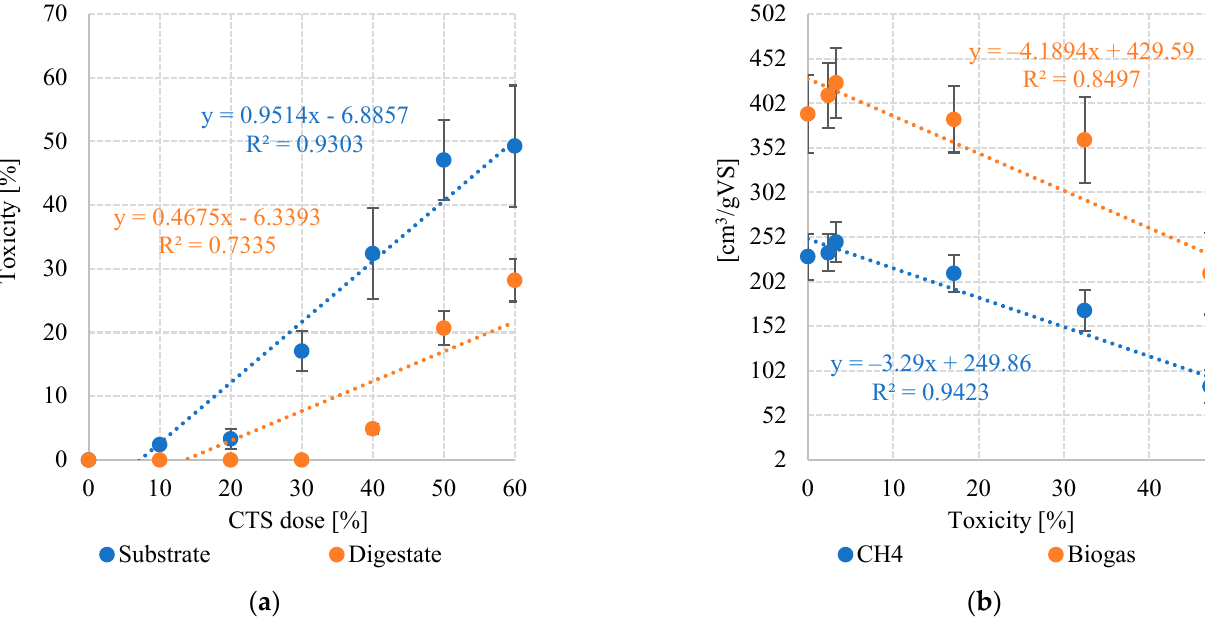
Figure 2. Correlations between ( a ) CTS in the feedstock and feedstock/digestate toxicity, ( b ) feedstock toxicity and biogas/CH 4 production. The contribution of basic taxonomic groups in the anaerobic bacterial community is shown in Table 5. The microbial communities consisted primarily of bacteria (EUB338), with proportions thereof falling within the narrow range of 68 ± 5% in V5 (40% CTS) to 71 ± 3% in V3 (20% CTS) (Table 5). No relationship was found between the CTS dose in the feedstock mixture and the share of bacteria in the anaerobic microbe community. Table 5. Percentage contribution of basic taxonomic groups in the anaerobic bacterial community (by experimental variant). Variant Taxonomic Group